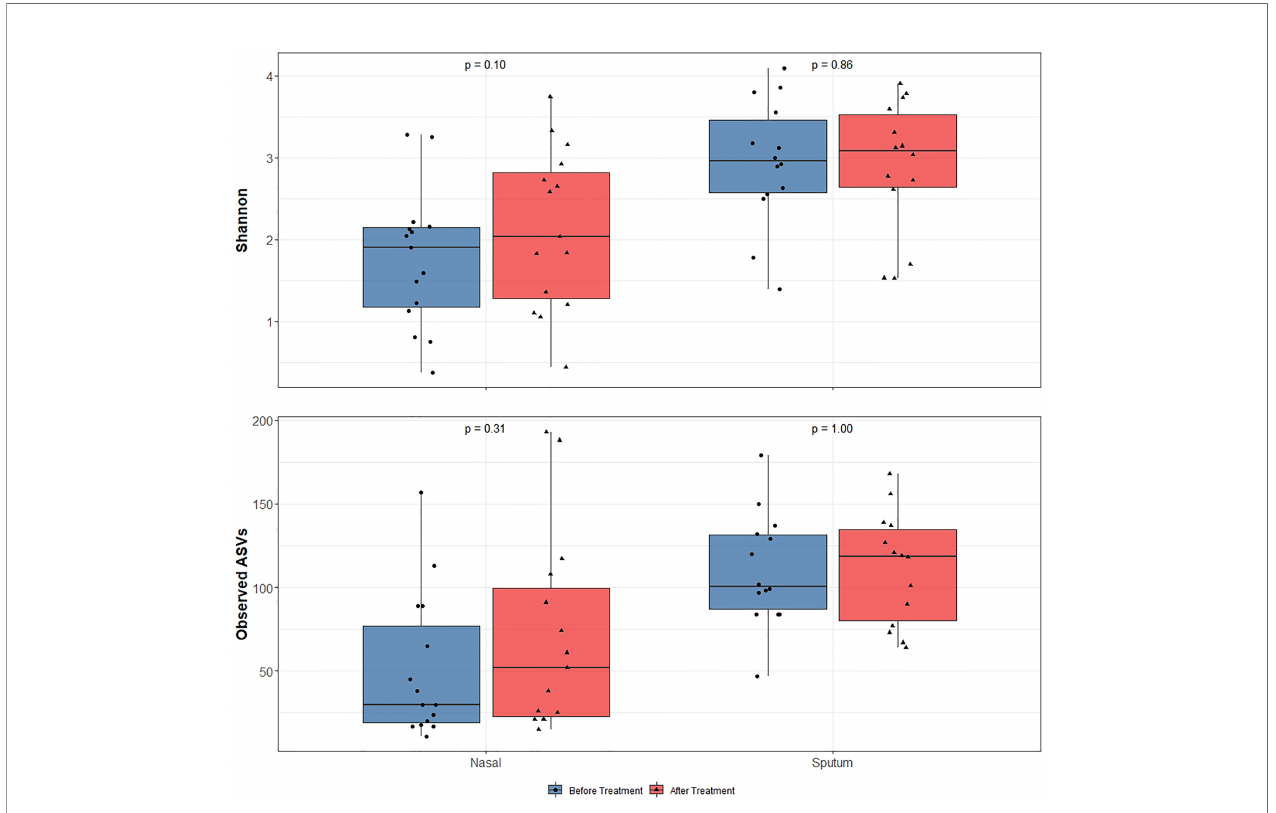
FIGURE 1 | 16S rRNA gene-based bacterial alpha-diversity in paired before and after treatment for bronchiectasis exacerbation in paediatric patients. After assessing data for normality using the Shapiro-Wilks test, signi fi cance was calculated by using a paired t-test for the Shannon diversity metric and Wilcoxon rank- sum test for the observed number of ASVs. Diversity was higher in sputum samples than nasal samples but diversity did not signi fi cantly change following antibiotic treatment in any sample